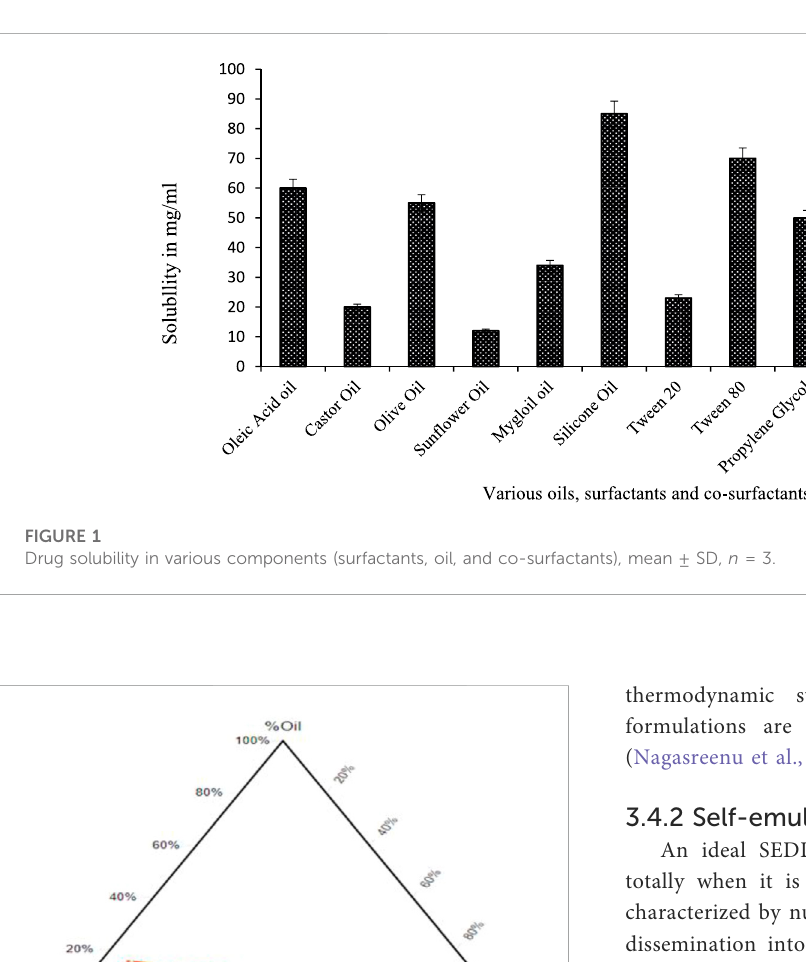
FIGURE 2 Pseudo-ternary phase diagram of oil – Smix2 –